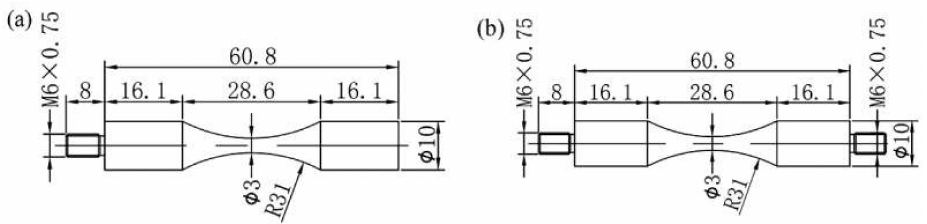
Figure 4. The size of the VHCF specimen (units: mm) [21], ( a ) R = − 1 and ( b ) R > 0.